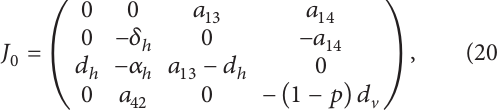
Figure 2: Bifurcation curves in (𝑅 0 , 𝐼 ℎ ) plane when 𝑟 = 0.8 , 𝐾 = 10 , = 1 , 𝑎 = 1 , 𝑎 = 0.1 , 𝑑 𝛽 1 1 2 = 0.06 , 𝛽 = 0.26 , and 𝑁 𝑑 V 2